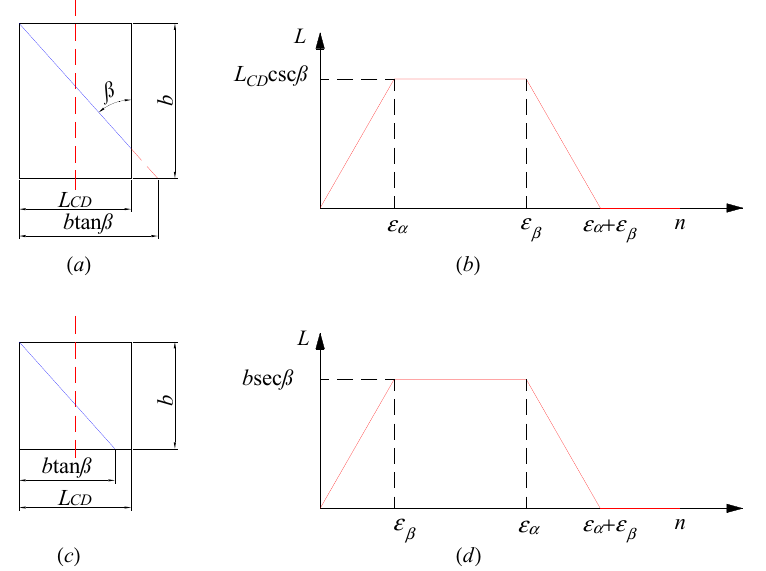
Figure 1. Time-varying contact line length of one mesh tooth pair of helical gear. ( a ) case: ε α ≤ ε β ; ( b ) Contact line length when ε α ≤ ε β ; ( c ) case: ε α > ε β ; ( d ) Contact line length when ε α > ε β